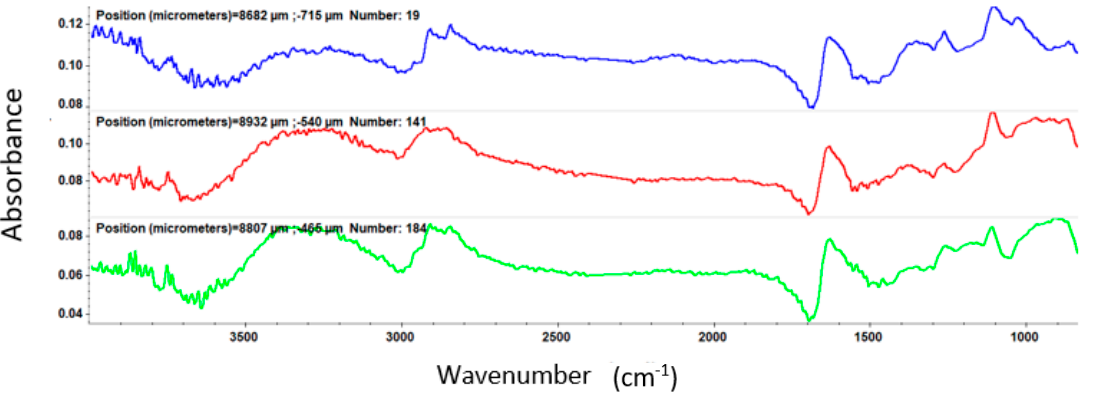
Figure 9. IR spectra of PVP/ZnO@LiN coatings at 400 mJ/cm 2 laser fluence.